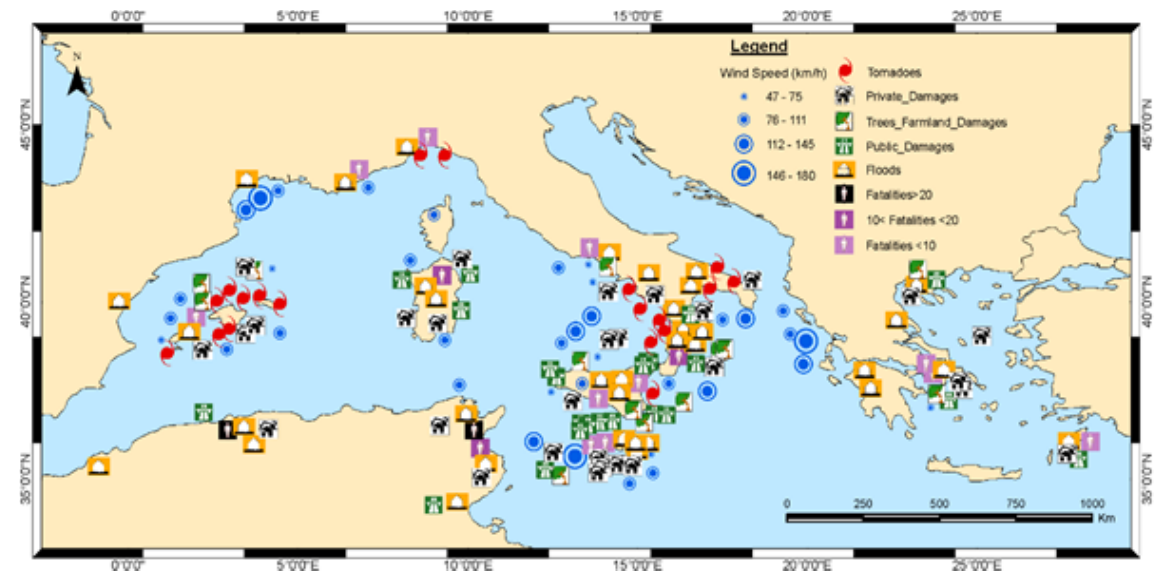
Figure 7. Geographical distribution of medicane impacts over the Mediterranean during the study period 1969–2014 (adapted from Nastos et al.,